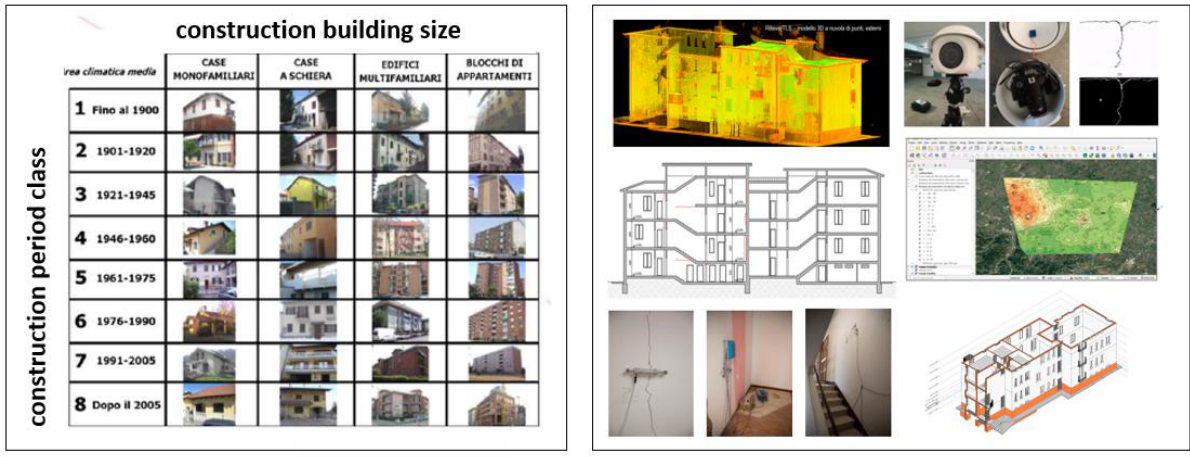
Figure 5. Comparison of data source types of the expeditious and non-expedient approach for defining the calculation algorithm. After input, events pass through one or more stream processors, which may route the data (e.g. to storage) or perform analysis and other types of processing. Wording of event data to secure offline storage for batch